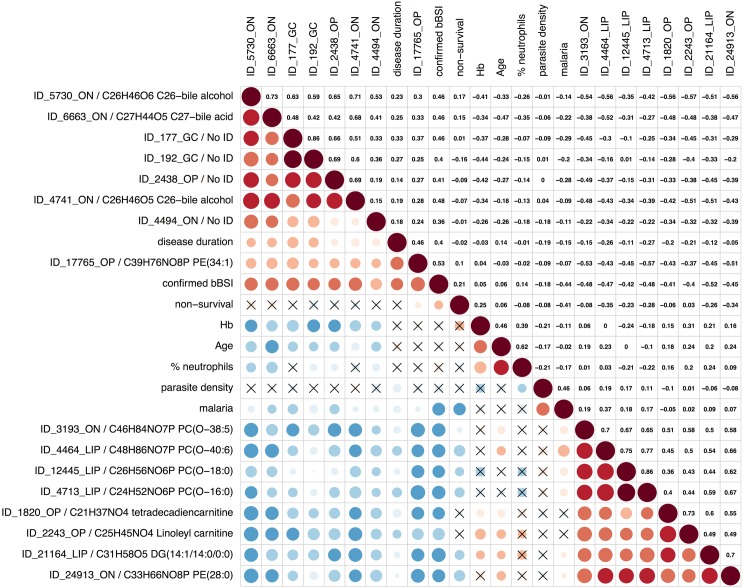
Plot showing correlation between clinical patient data and the metabolite features characterizing BSI.The plot consists of 2 panels: (i) in the lower panel, the color and size of the circles correspond to the strength of the correlation, with increasing circle size and color intensity indicating increasing correlation; shades of blue are used for negative correlations and shades of red for positive correlations, crosses indicate correlations that were statistically insignificant (p-value < 0.05), and (ii) the upper panel shows the corresponding Pearson’s correlation coefficient r. The left labels for metabolites include the feature ID of the metabolite as listed in S1 data and one putative identification. The following eight patient variables were included: confirmed BSI = confirmed or no confirmed BSI diagnosis; malaria = positive or negative malaria blood smear; parasite density = number of asexual Plasmodium parasites in the bloodstream (x103/mL); disease duration = duration illness prior to hospital admission expressed in days; non-survival = clinical outcome survival or no survival; age = age expressed in months; Hb = blood hemoglobin level (g/dL); % neutrophils = neutrophils as % of total WBC. Lipids are abbreviated with PC, PE, SL, DG or TG for phosphatidylcholines, phosphatidylethanolamines, sphingolipids, diacylglycerides and triacylglycerides respectively, and the total number of acyl side-chain carbons and the double bonds in the side-chains.